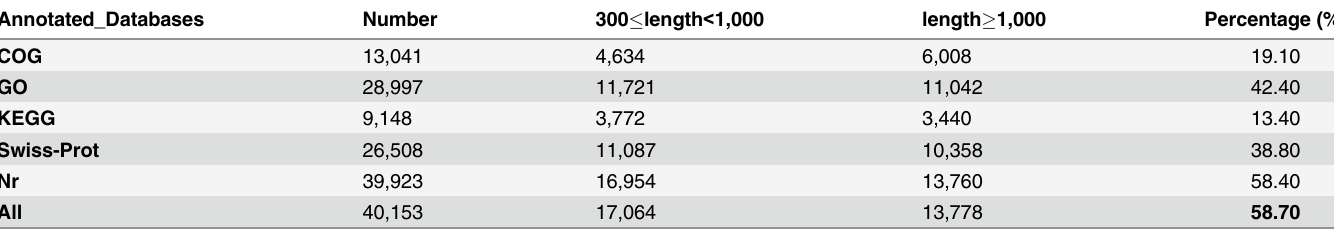
database, with a BLAST threshold of less than 1E-5 [37]. Out of the 68,373 unigenes, 40,153 (58.70%) significantly matched sequences deposited in the public protein databases (Table 3). Table 3. Summary of sequence